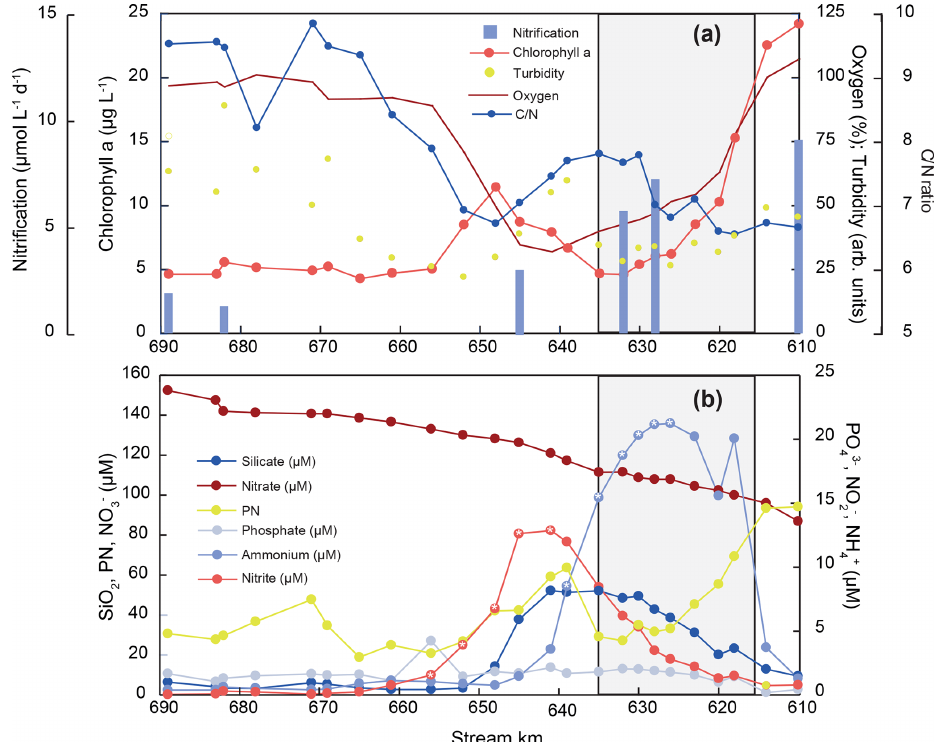
Figure 2. Nutrient concentration, particulate matter composition, biogeochemical trends, and nitrification rates along the Elbe Estuary. The harbor region is indicated by shading, and white asterisks mark the sampling points that were used for the estimation of the isotope effects of nitrite and ammonium removal, respectively.